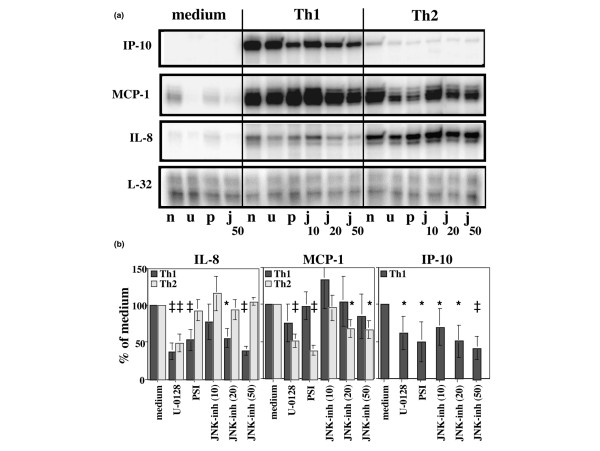
IL-8, MCP-1 and IP-10 mRNA in fibroblasts activated by T cell contact and effect of inhibitors. Fibroblasts were plated to confluence resulting in about 1 × 106 cells per Petri dish. They were serum starved overnight, and T cell membranes equivalent to 8 × 106 cells from Th1 and Th2 clones were then added for 4 hours in 1% FCS medium. Intracellular signalling inhibitors were added one hour before adding T cell membranes. Total fibroblast RNA was isolated and mRNA levels were assessed by RNase protection assay. (a) A representative analysis from five performed. n = nil; u = U-0126 (40 μmol/l); p = PSI (40 μmol/l); j = JNK inhibitor (10, 20 and 50 μmol/l). (b) mRNA signal intensity was determined densitometrically and normalized values, computed by dividing chemokine by housekeeping probe signals, were used to evaluate the effect of T cell contact and intracellular signal inhibitors. The bars represent the percentage of the chemokine signal intensity measured in the presence of T cell membranes with intracellular signal inhibitors divided by the signal obtained in the presence of T cell membranes without inhibitors. Shown is the mean ± standard deviation of five distinct experiments. Statistically significant differences versus medium: *P < 0.05, ‡P < 0.001. ERK, extracellular signal-regulated kinase; FCS, foetal calf serum; IFN, interferon; IL, interleukin; IP, interferon-γ inducible protein; JNK, c-Jun N-terminal kinase; MCP, monocyte chemoattractant protein; PSI, proteasome inhibitor I; Th, T-helper; TNF, tumour necrosis factor.